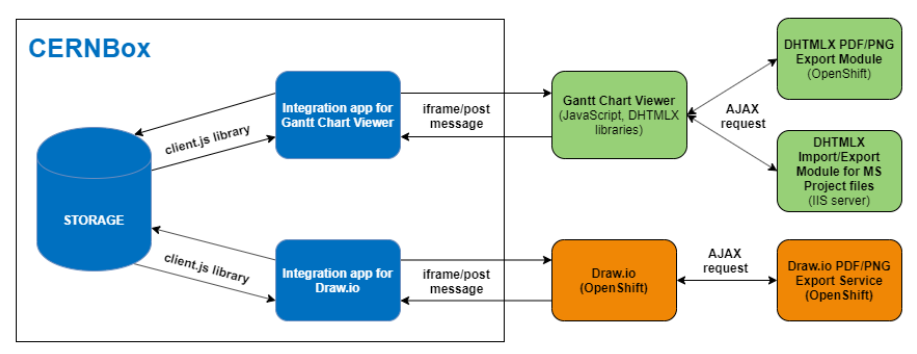
Figure 2: Integration of Gantt Chart Viewer and Draw.io with